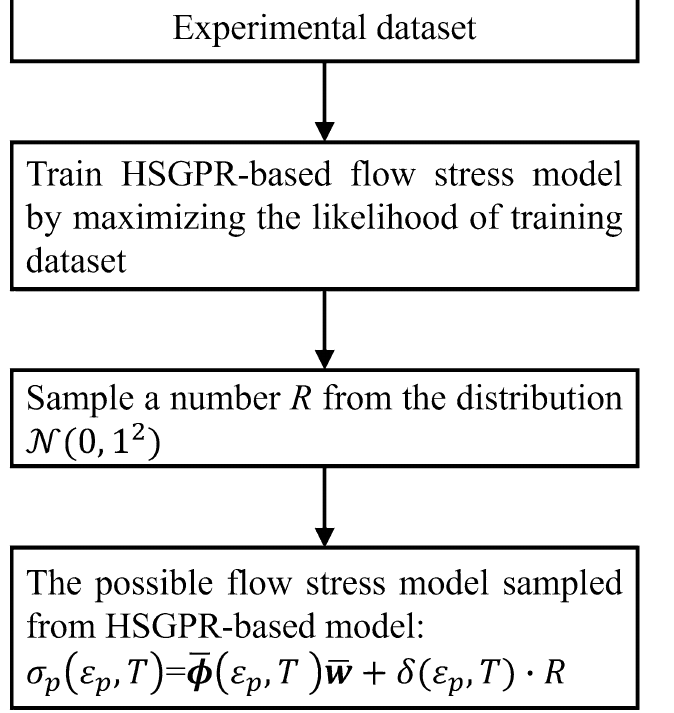
Figure 1. The flow chart of establishing HSGPR-based stochastic flow stress model.